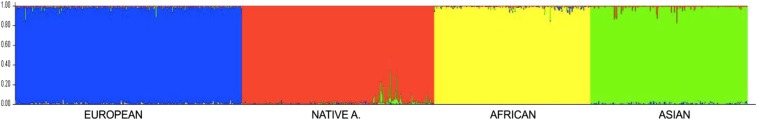
Schematic representation of the interethnic admixture estimates in the four continental populations, using Structure software for k = 4. Barplot: each vertical line represents an individual and the proportion of admixture of European (blue), Native American (red), African (yellow) and Asian (green) populations.